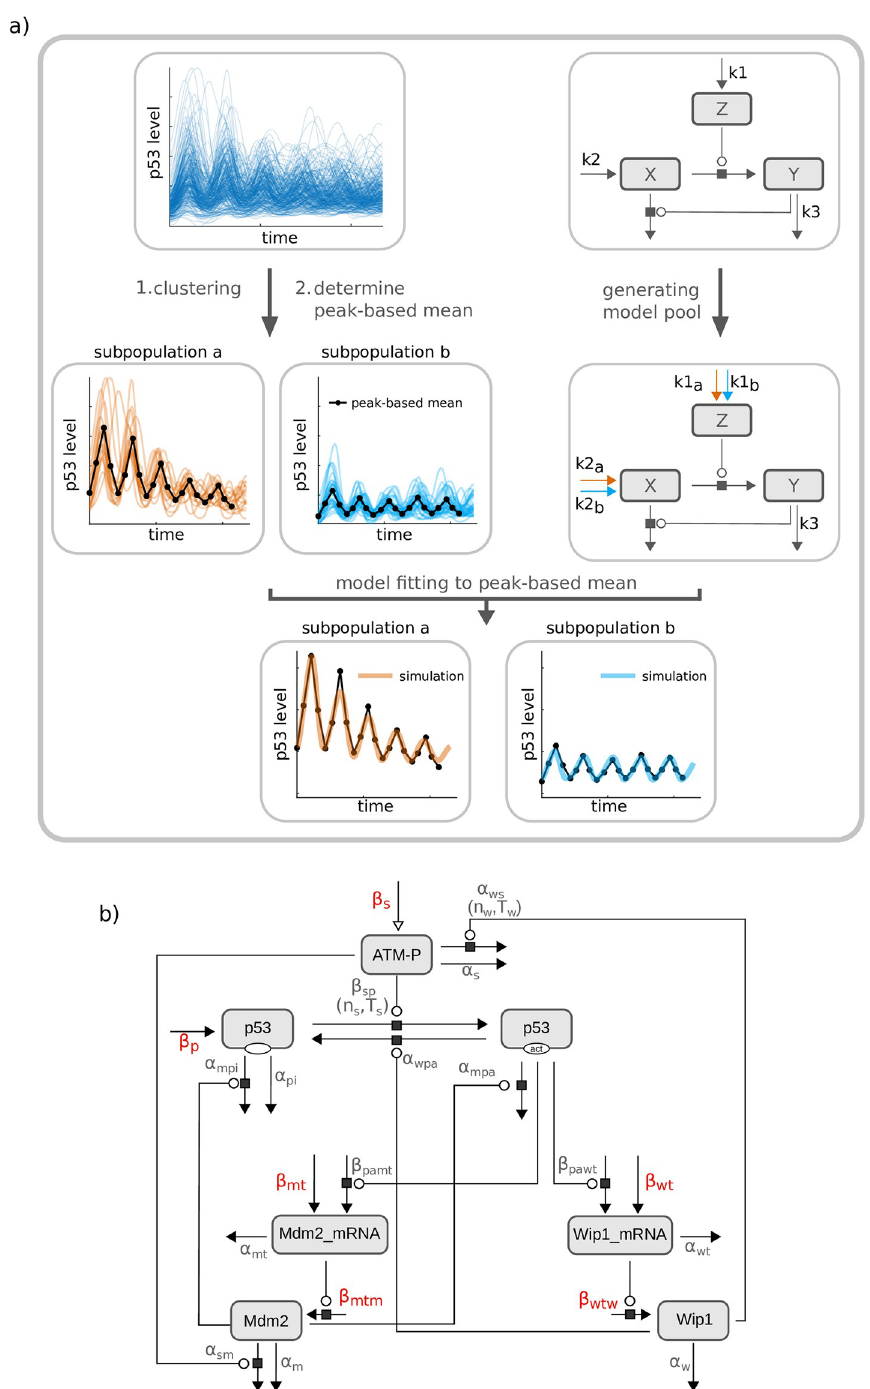
Fig 2. Scheme of the subpopulation modeling framework and the model describing the p53 network. a) Single cell trajectories are clustered into subpopulations with similar dynamics (upper left panel). For each cluster, a peak-based mean is calculated, representing subpopulation-specific dynamics. To account for cellular heterogeneity and to reproduce the different dynamics of subpopulations, a pool of models is generated (upper right panel). In this example, the model pool comprises two models, one is specific for subpopulation a , the other one for subpopulation b . The production rates of Z and X are assumed to be susceptible to noise. Hence, parameters of these two processes are considered subpopulation-specific and therefore specific for an individual model. While k1 subpopulation a and thus assigned to one model, k1 b and k2 b are specific for subpopulation b and assigned to